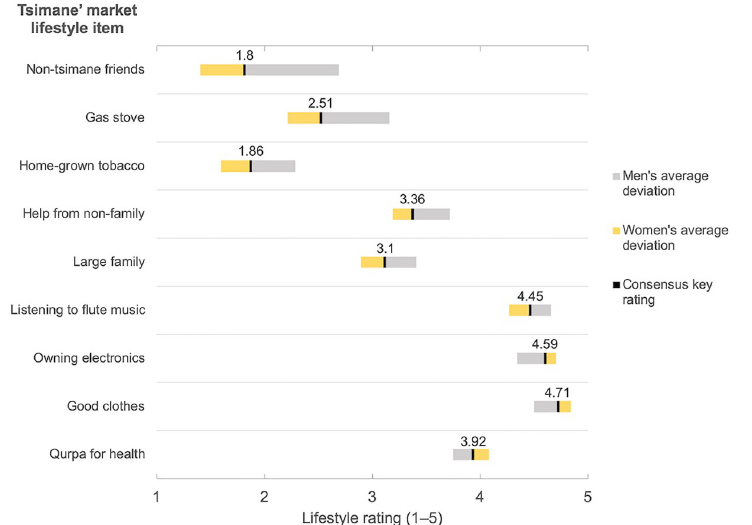
Fig 5. Largest ratings deviations (upper quartile) from market lifestyle by gender.